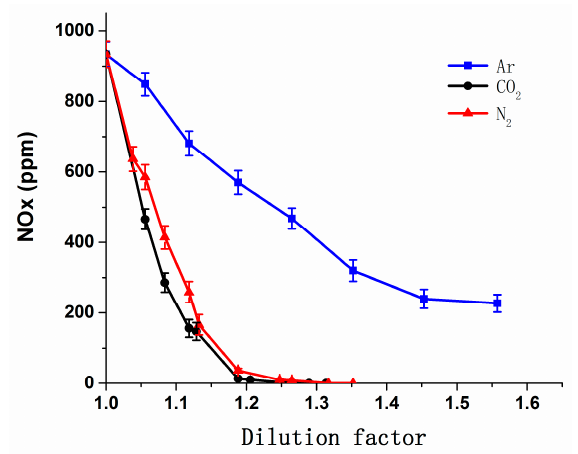
Figure 11. Variation in NOx emissions vs. the DF of CO 2 , N 2 , and Ar.